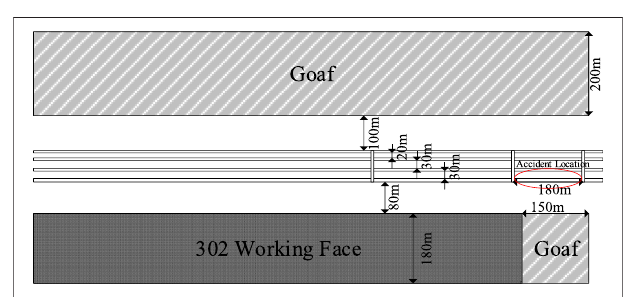
FIGURE 4 | Schematic of the location of the